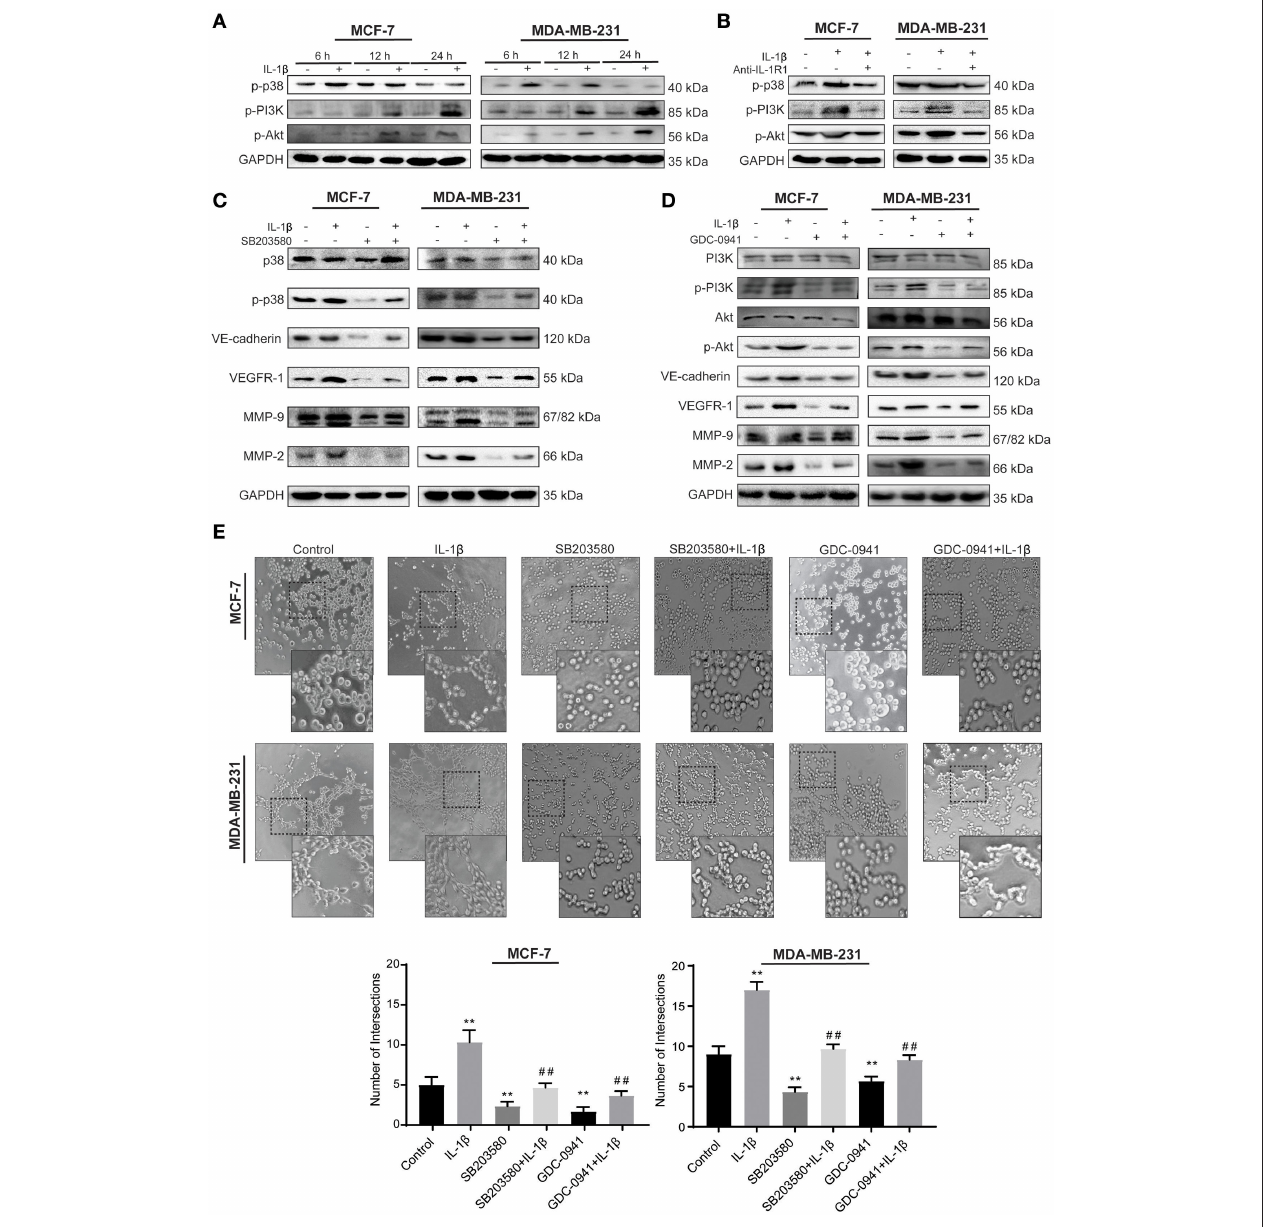
FIGURE 4 | IL-1 β facilitates VM responses via p38/MAPK and PI3K/Akt signaling pathways. (A) Time-dependent analysis of p38/MAPK and PI3K/Akt signaling pathways activation via western blot after cells treated with IL-1 β . (B) p-p38, p-PI3K, and p-Akt treated by IL-1R1 is analyzed via western blot in cells treated with IL-1 β and IL-1R1 antibody (1 µ g/ml). (C) Expression of VM biomarkers in cells treated with p38/MAPK inhibitor (SB203580, 10 µ M for MCF-7 cells, 7 µ M for MDA-MB-231cells), and IL-1 β . (D) Expression of VM biomarkers in cells treated with PI3K/Akt inhibitor (GDC-0941, 5nM for MCF-7 cells, 3nM for MDA-MB-231 cells) and IL-1 β . (E) Cord formation assay was performed in cells treated with SB203580 or GDC-0941. Statistical analysis was performed through multiple t -test comparisons with significance of ** p < 0.01 compared to the control group, where as ## p < 0.01 represent the statistical comparison with the IL-1 β treated group. Statistical analysis of (A–D) is represented in Supplementary Figure 2